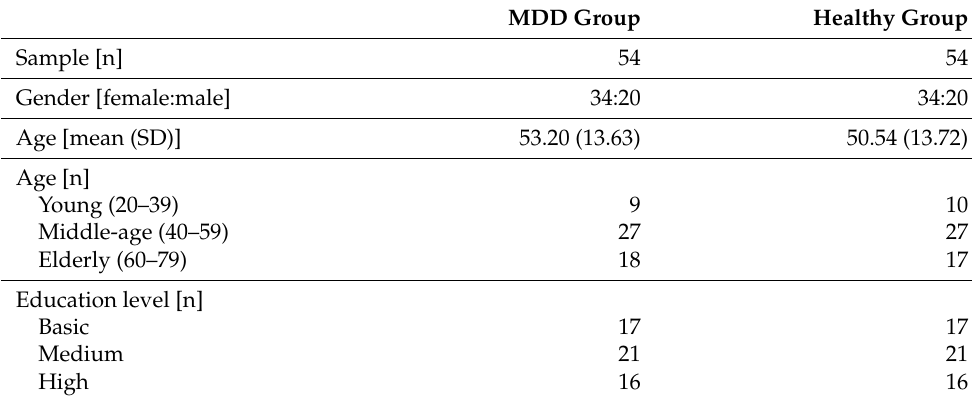
Table 1. Sociodemographic data.